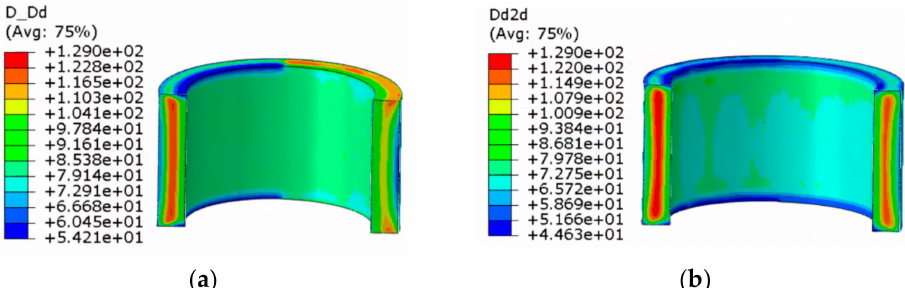
Figure 11. Nephogram of dynamic recrystallization grain size distribution without considering the shear effect: ( a ) first pass rolling; ( b ) second pass rolling.